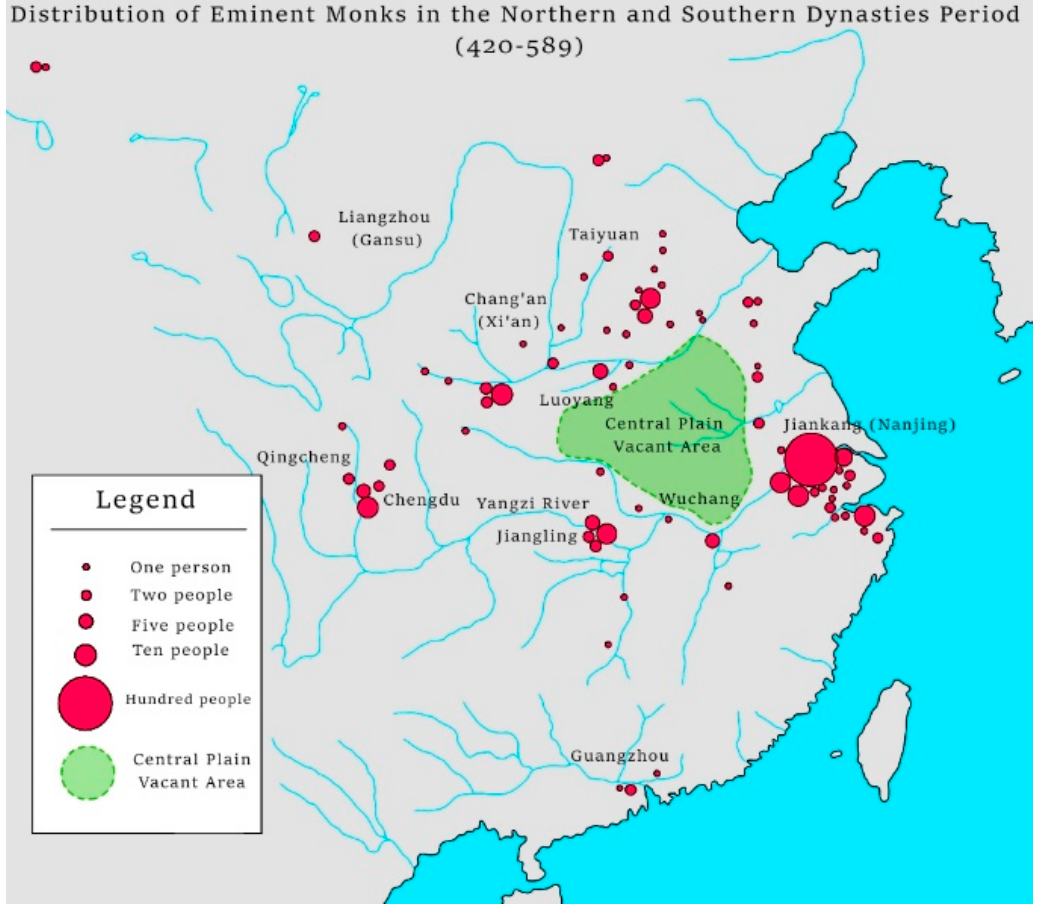
Figure 2. Central plain vacant area, indicated by the distribution of eminent monks in the Northern and Southern Dynasties period. Source: Yan Gengwang, Weijin Nanbeichao Fojiao dili shigao , pp. 46–47.